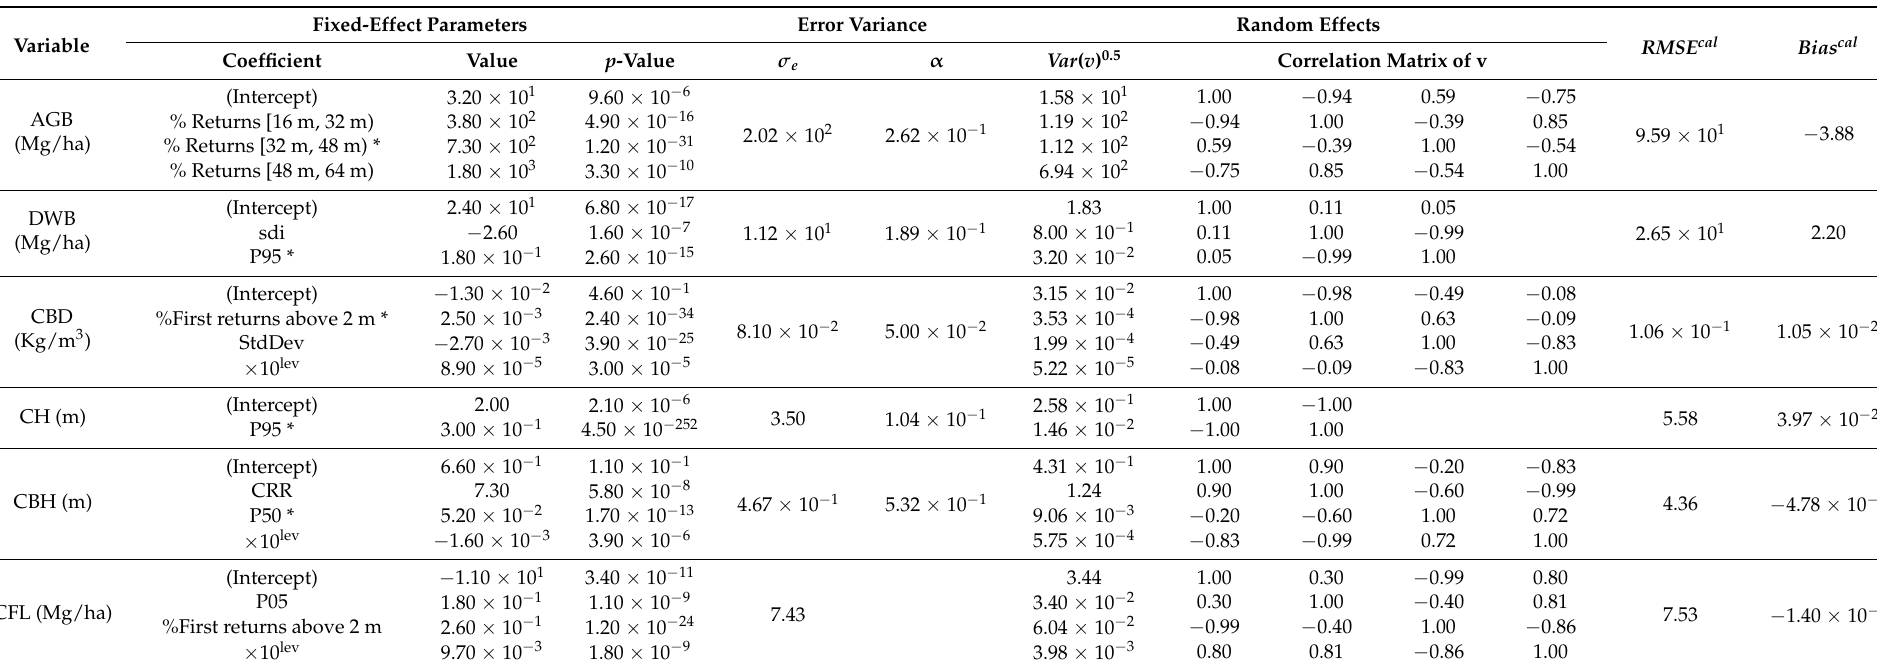
Table A4. Parameters and global performance metrics of linear mixed-effects models using point-cloud ALS predictors. * Indicates the most correlated predictor used to model heteroscedasticity. Model response variables are: aboveground biomass (AGB), downed woody biomass (DWB), canopy bulk density (CBD), canopy height (CH), canopy base height (CBH), and canopy fuel loading